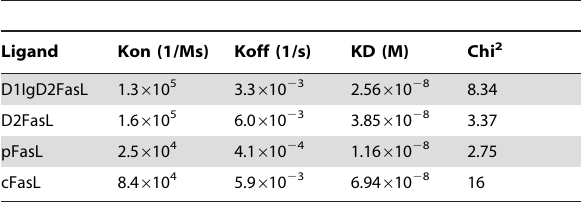
Table 1. Association/dissociation constants of the soluble FasL